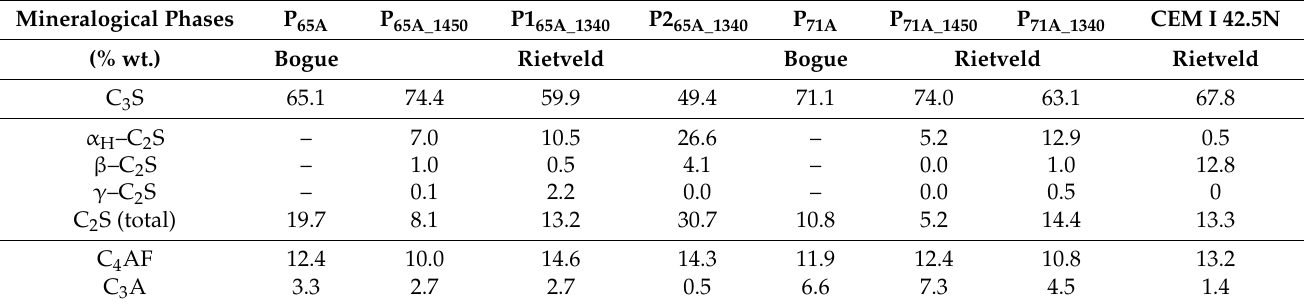
Table 6. Main crystallographic phases of clinkers by Bogue predictions and Rietveld results by